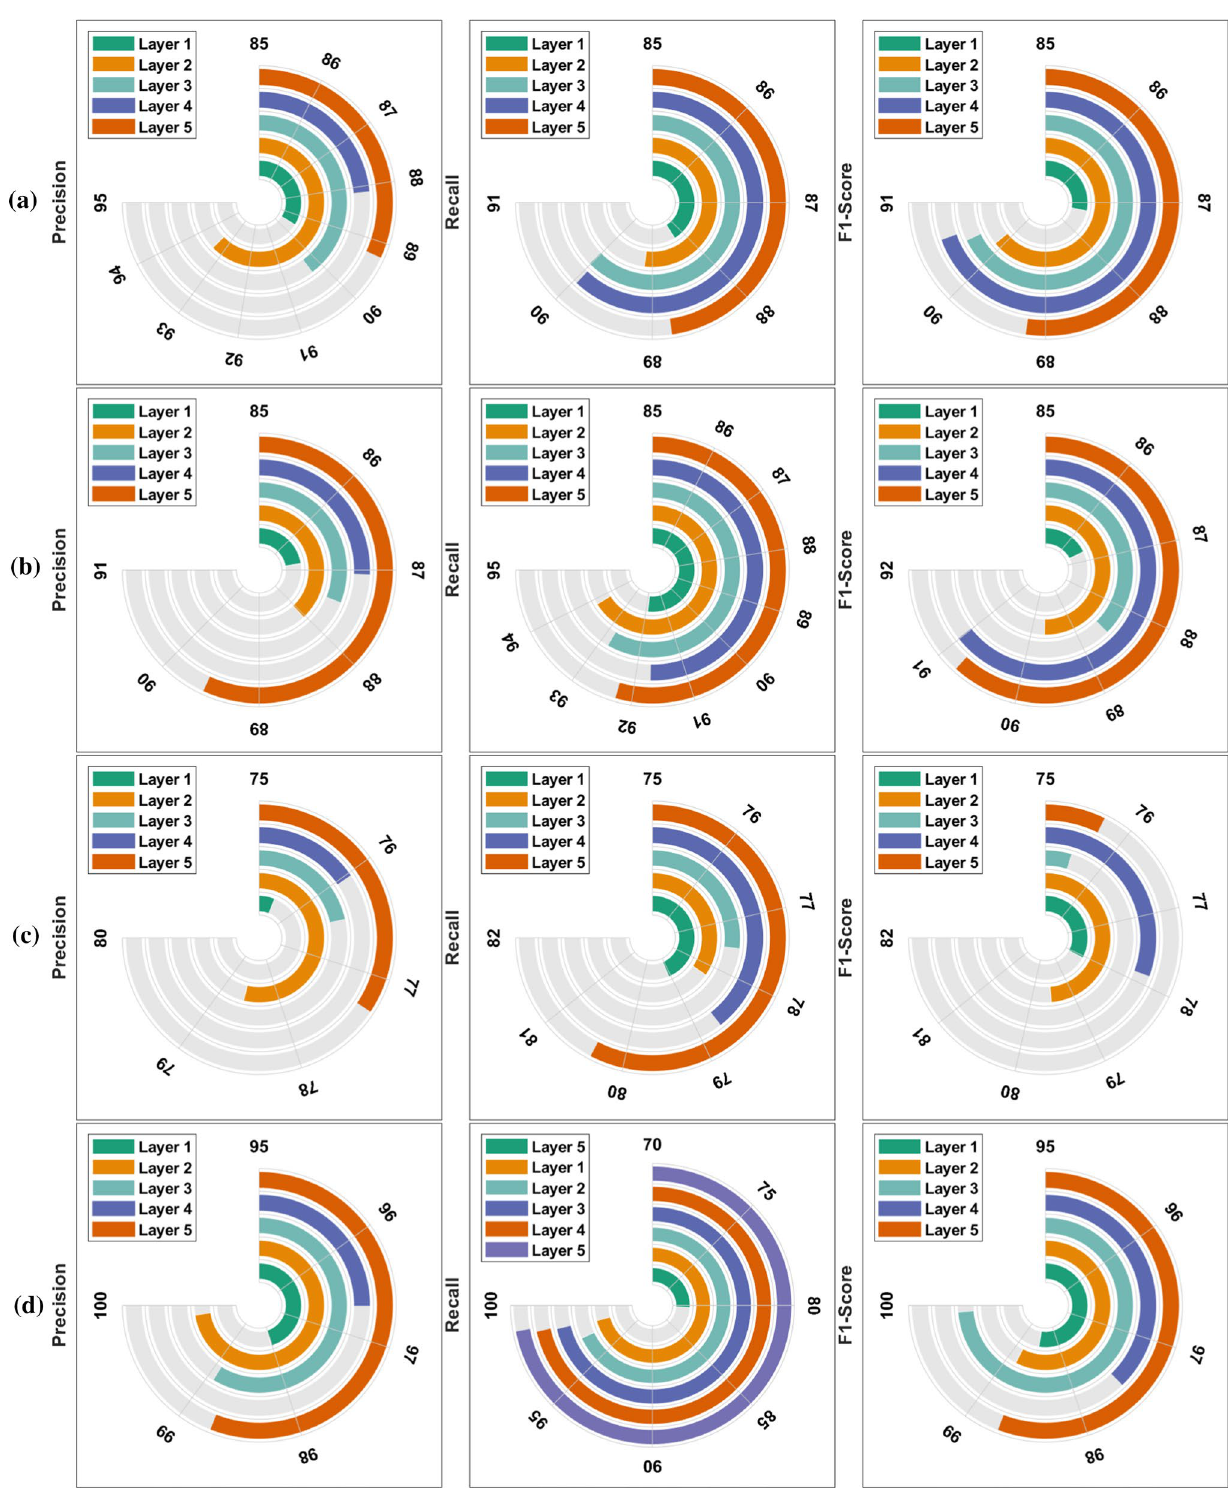
Fig. 5 Results of Proposed Method a Dataset-1 non-cyberbullying b Dataset-1 cyberbullying c Dataset-2 non-cyberbullying d Dataset-2 cyber-